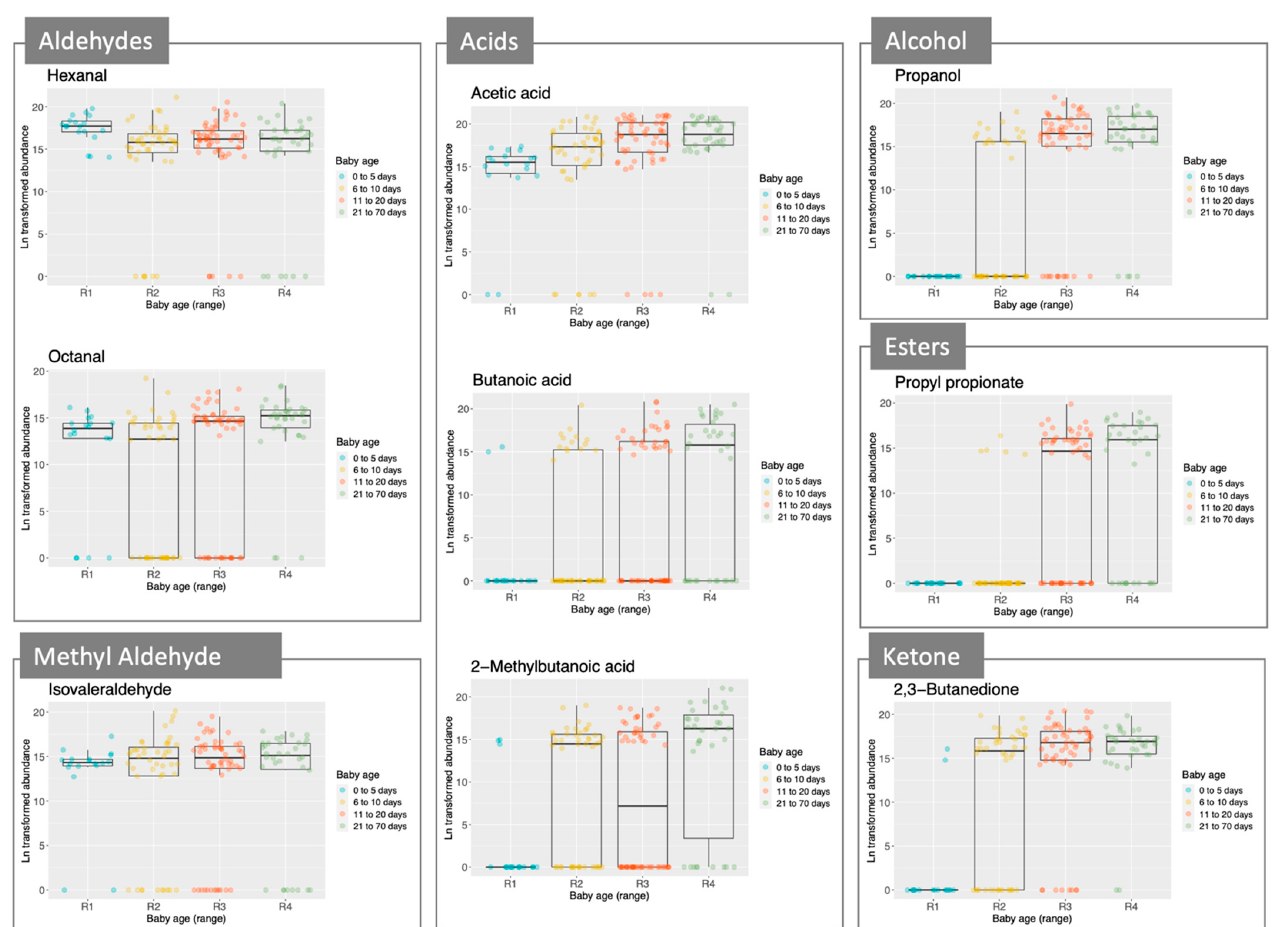
Figure 2. Boxplots for a selection of compounds (abundance/age group). Each boxplot represents a compound, and these are grouped according to the type of molecule (i.e., aldehydes, methyl aldehydes, acids, alcohol, esters, and ketone). All samples were included, n = 152.